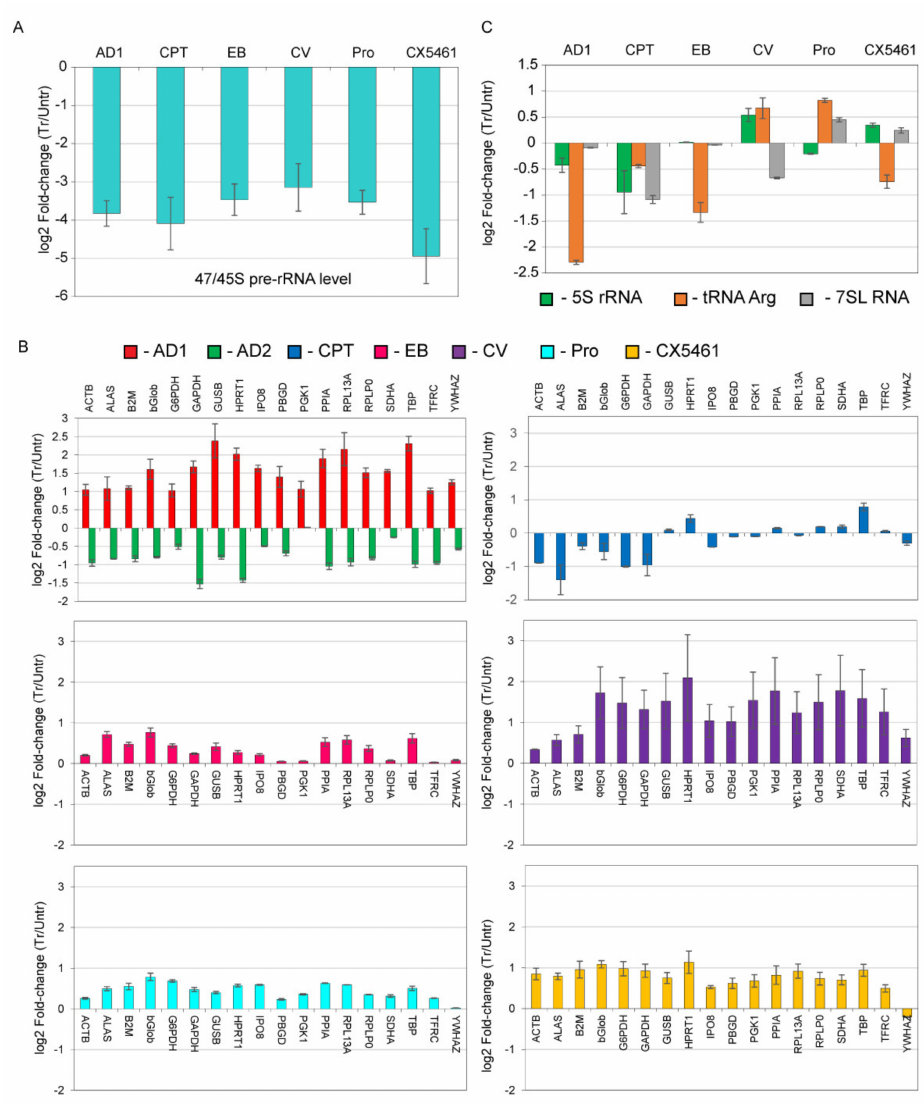
Figure 5. Intercalators have limited effect on general transcription by Pol-II and Pol-III in p53